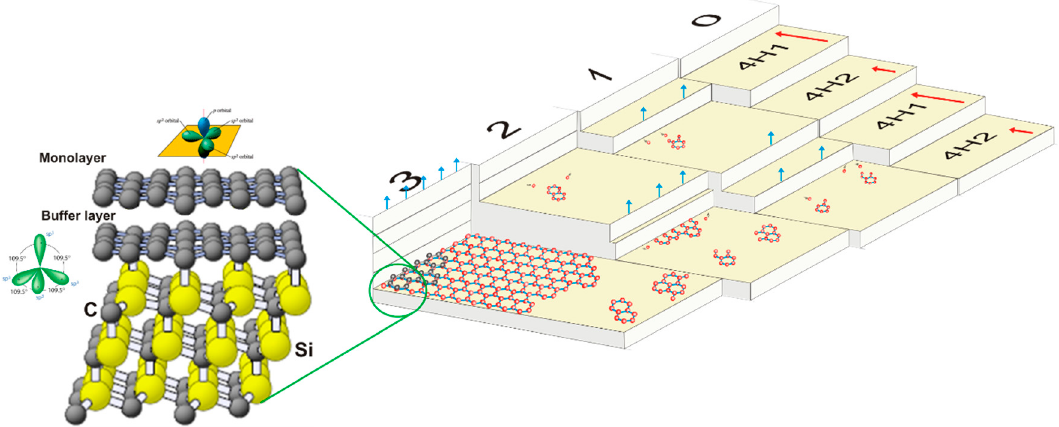
Figure 15. Schematic depiction of the formation process of epitaxial graphene via sublimation of Si from the SiC surface [22].